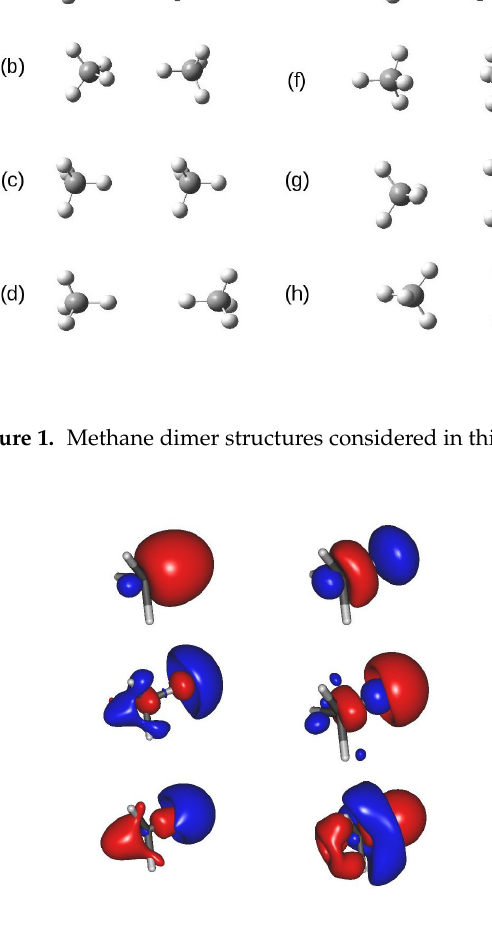
Figure 2. Two center (C–H) localized basis set orbitals of